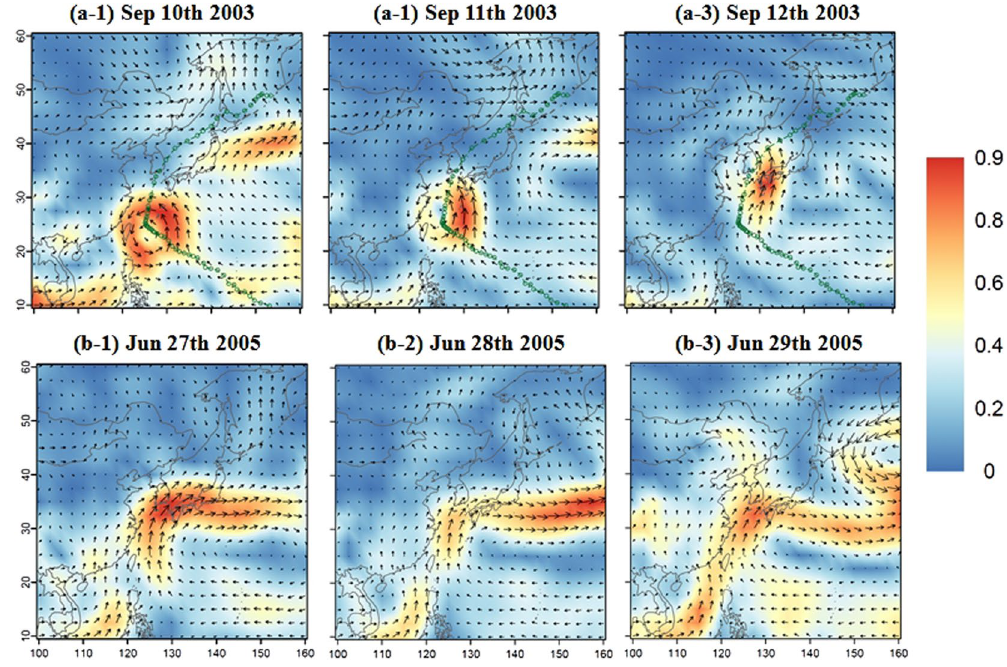
Figure 1. Two extreme rainfall events of the TC case (TC Maemi) in the top panels ( a-1 ~ a-3 ) and the non-TC case (monsoon rainfall) in the bottom panels ( b-1 ~ b-3 ). Note that blue to red shading represents the strength of VIMF (unit: g/kg · m/s); arrows indicate the mean wind vector over the vertical range between 1000 hPa and 750 hPa, and a green dotted line with circles in the top panels represents the TC path starting from the right bottom and heading northward. The maps were created using software “R studio Desktop, [1.0.44 version],